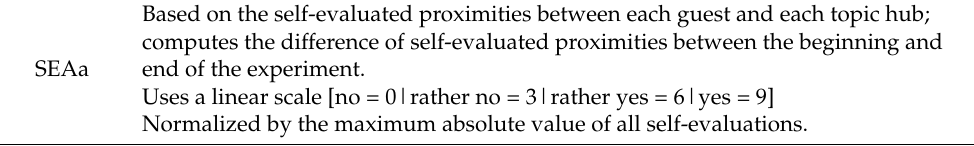
Table 3. The indicators.